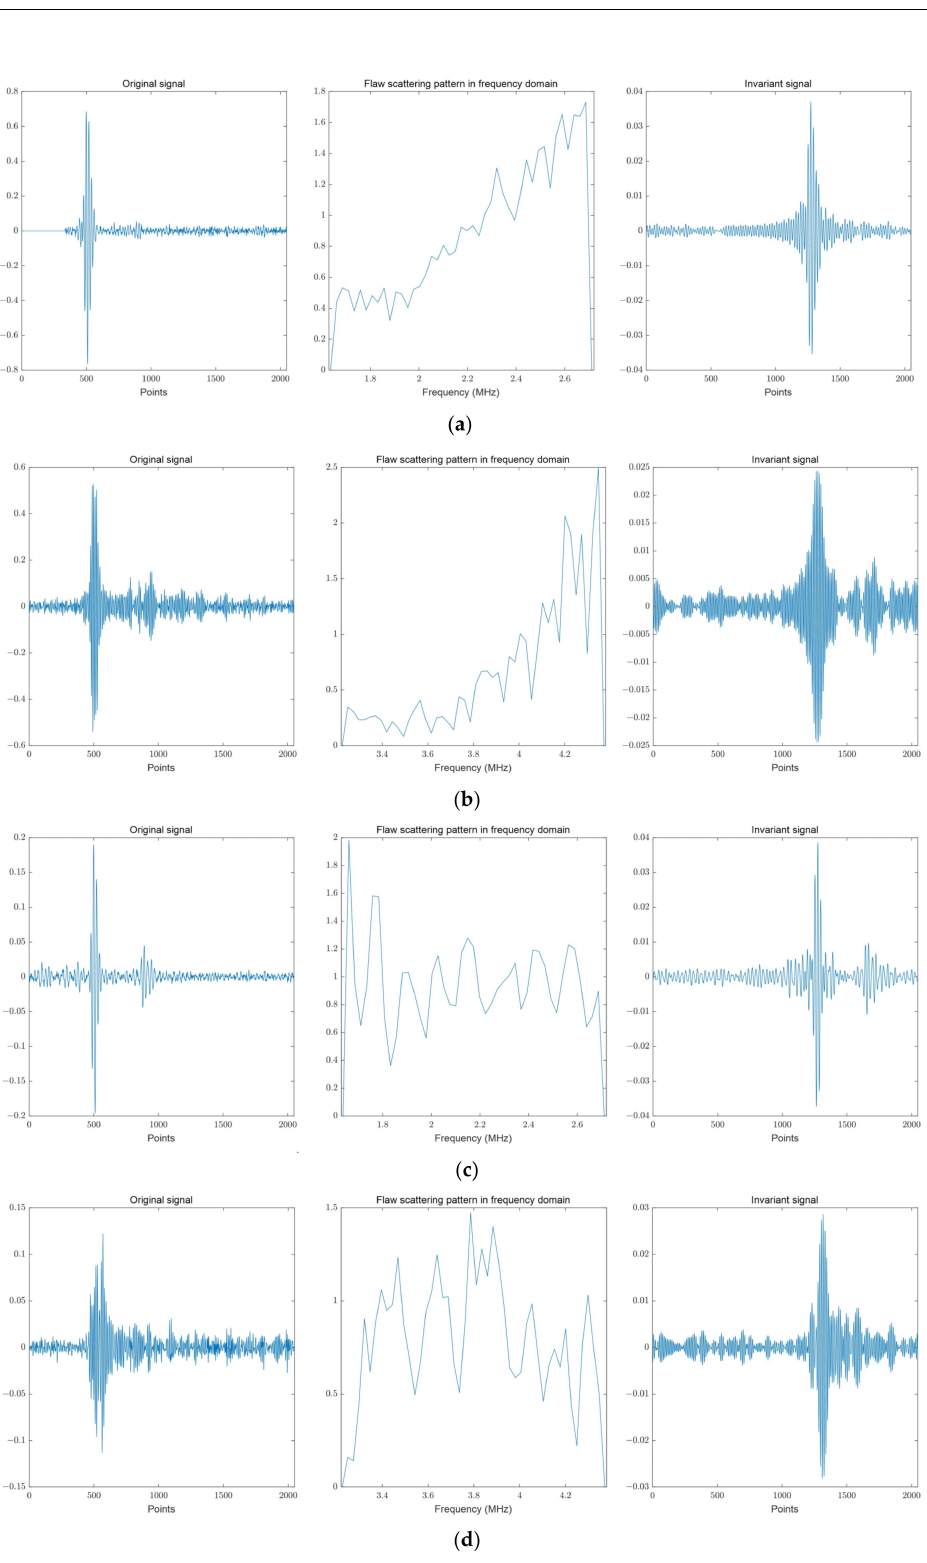
Figure 8. Examples of cracks and porosity signals when applying system invariant method, from left to right: original signal, flaw scattering pattern in the frequency domain, and invariant signal; ( a ) crack signal with Olympus A430S (45 degrees, 2 MHz); ( b ) crack signal with KrautKramer WB70-4 (70 degrees, 4 MHz); ( c ) porosity signal with Olympus A430S (45 degrees, 2 MHz); ( d ) porosity signal with KrautKramer WB70-4 (70 degrees, 4